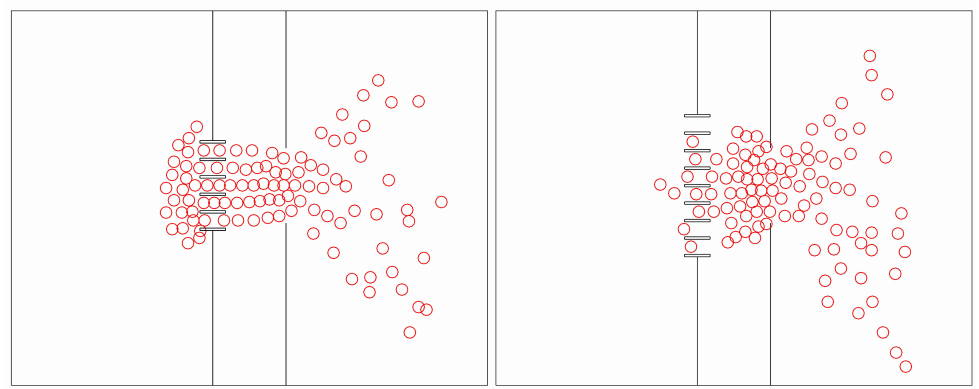
Figure 8. Changes in crowd evacuation time with the number of passages under different exit width conditions.